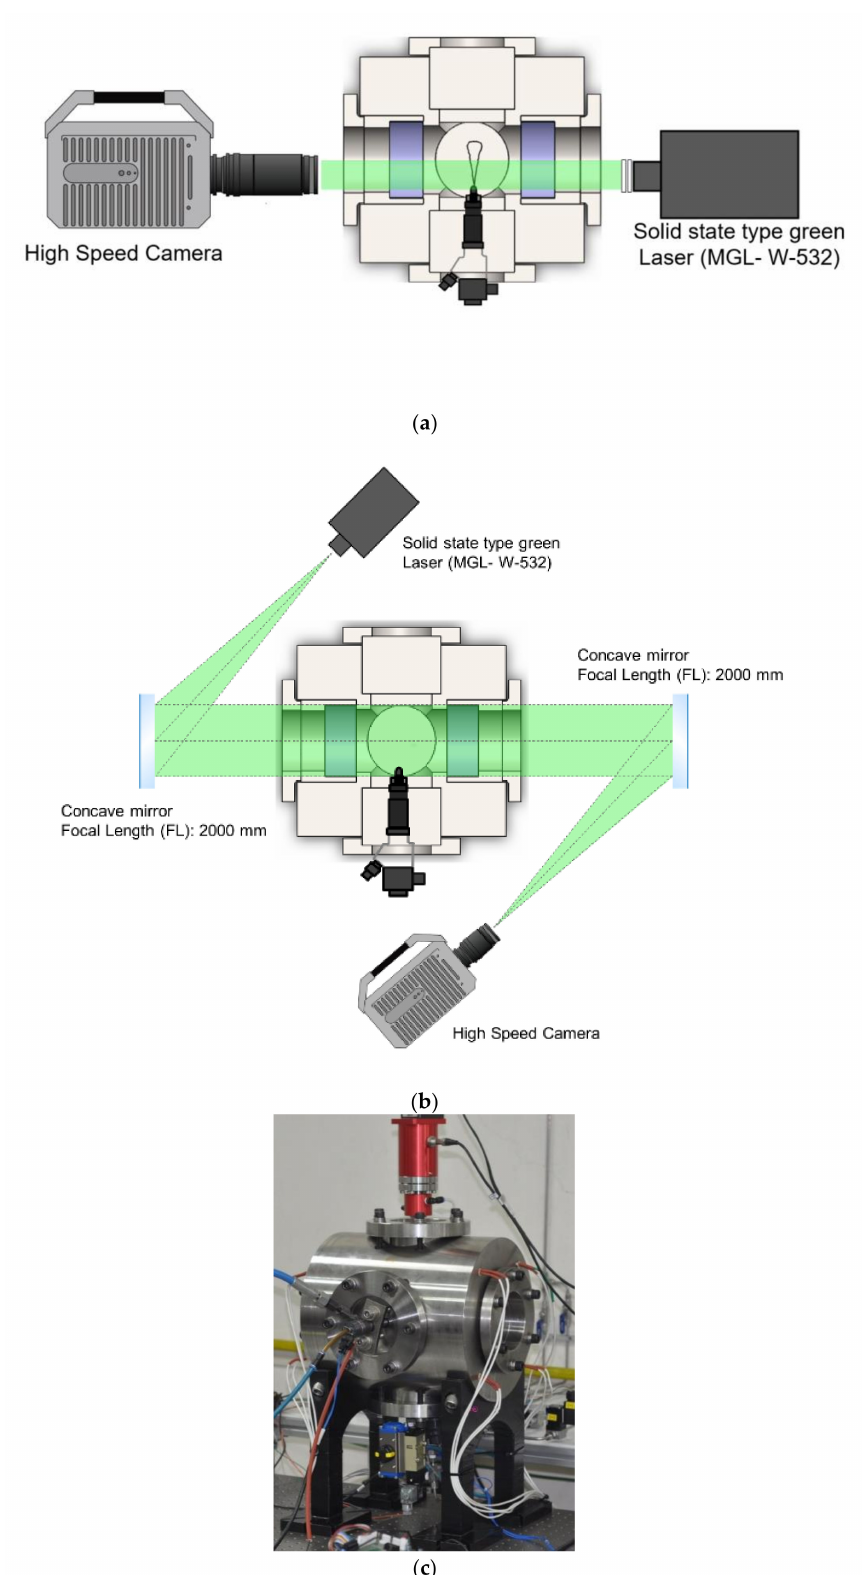
Figure 2. Optical setups for ( a ) the microscopic spray, ( b ) macroscopic spray visualizations, and ( c ) the constant volume chamber